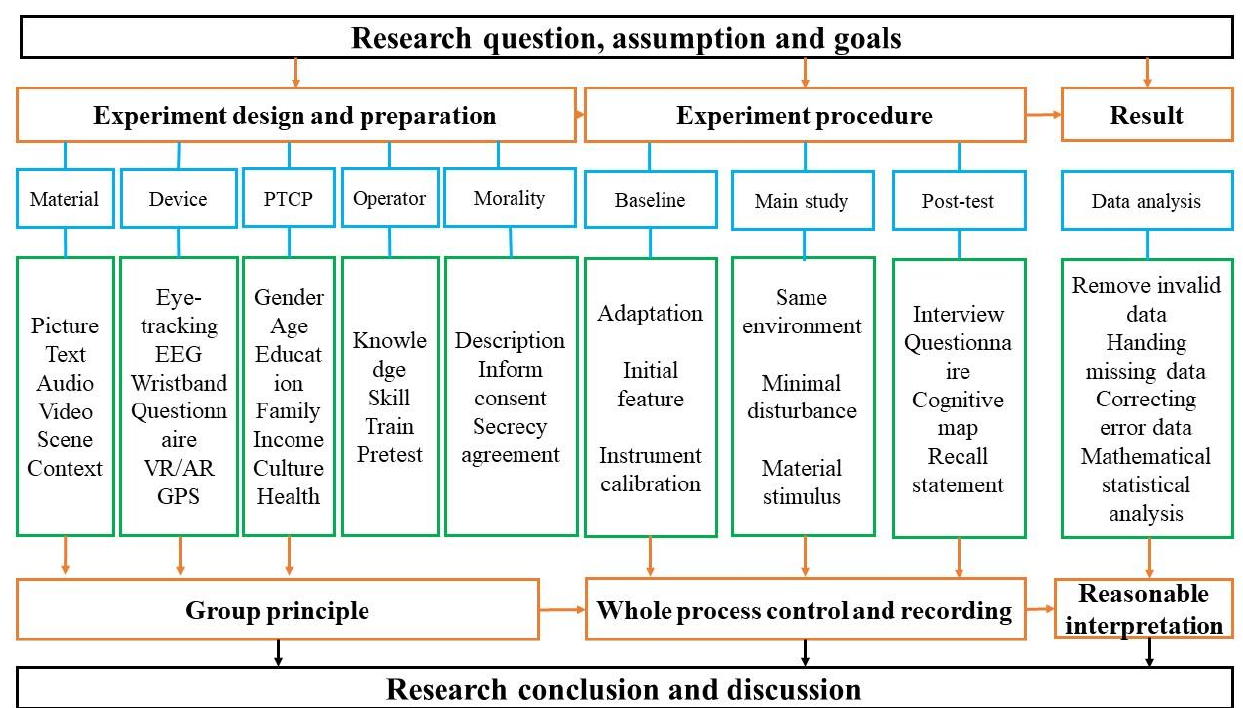
Figure 3. Neuropsychological experiment process. Drawn by the authors.